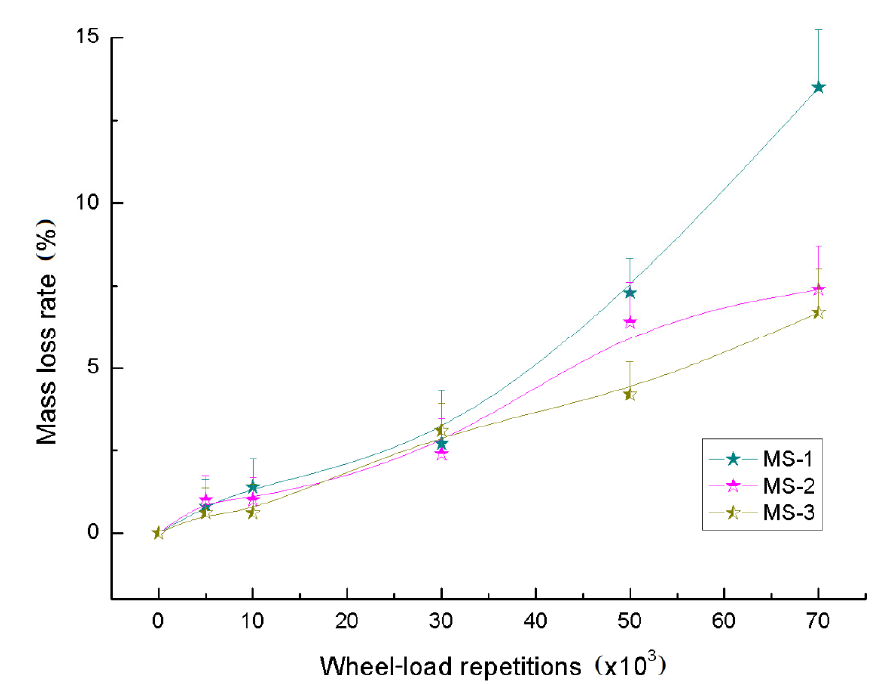
Figure 12. Spalling mass-loss rate under different wheel-load repetitions.